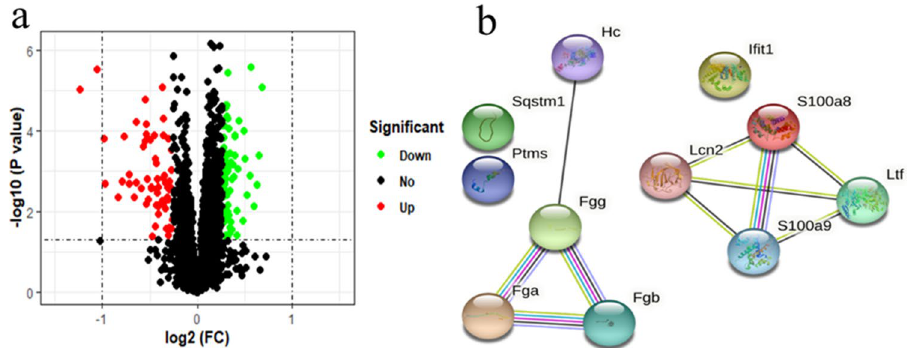
Figure 7. Visualization of the differentially expressed proteins. ( a ) Volcano plot displays the differentially expressed protein-coding proteins. ( b ) Protein–protein interaction network of the 11 genes which involved in the immune system, this network were constructed using STRING database which is publicly available (STRING version: 11.0 23